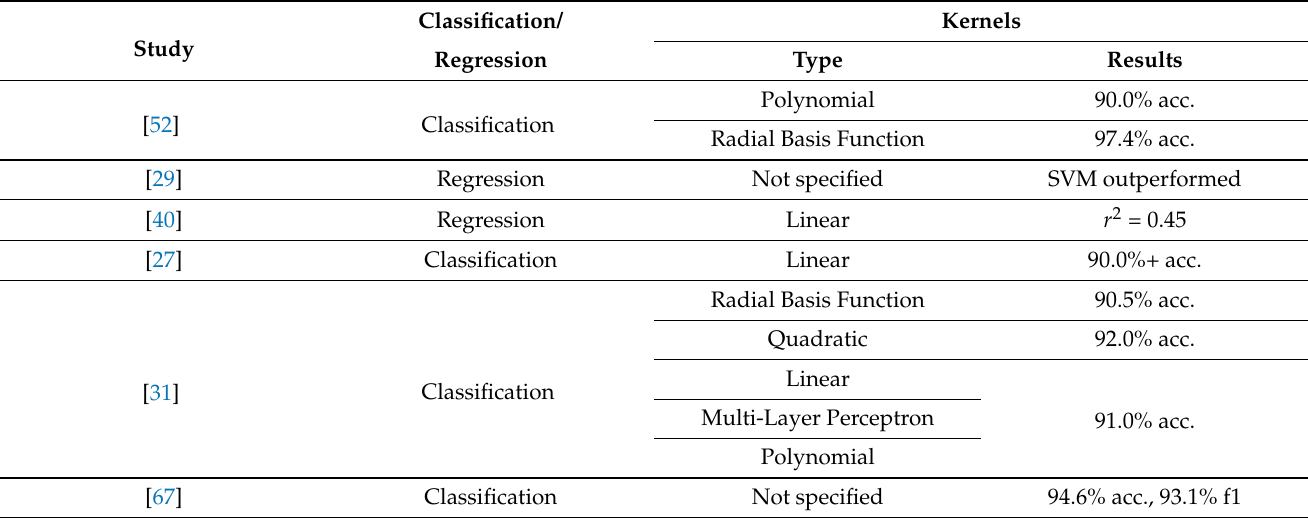
Table 3. SVM performance.